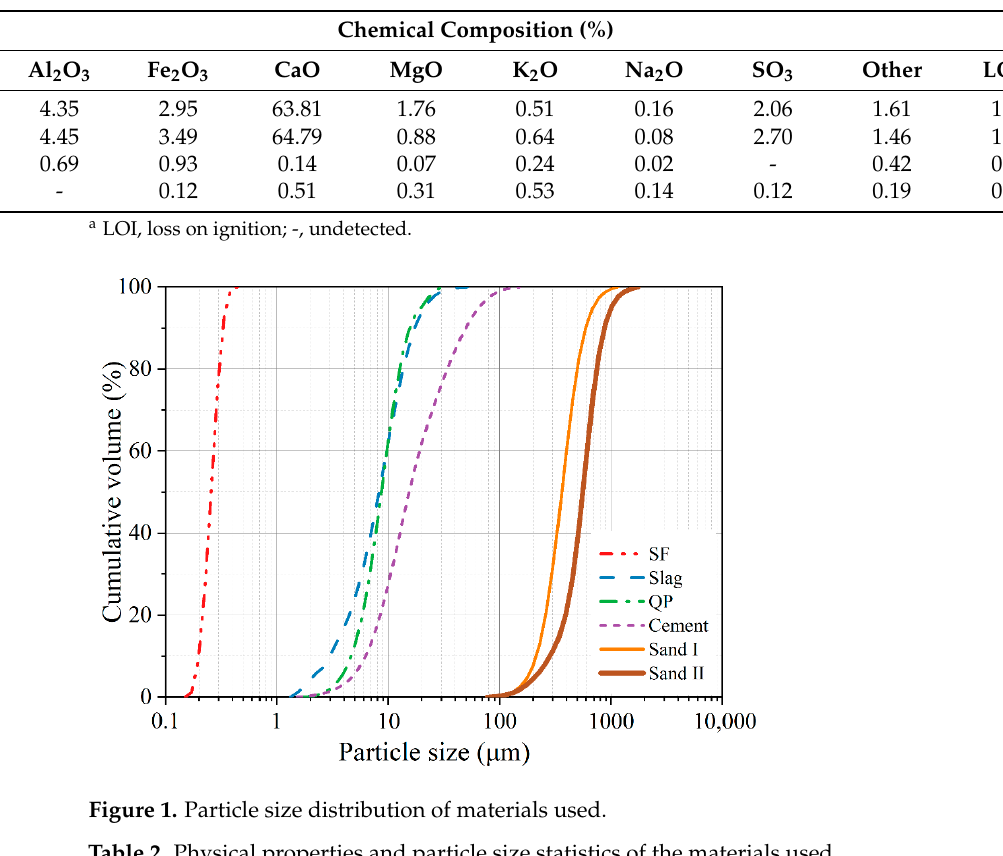
Table 1. Chemical compositions of the materials used.